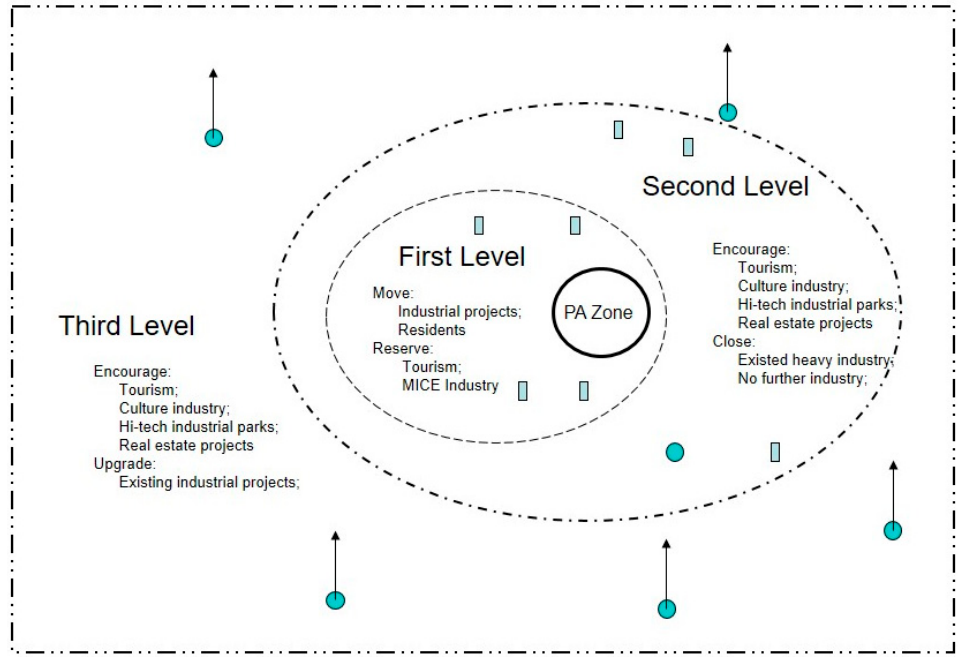
Figure 4. Three levels of construction control (an abstraction).